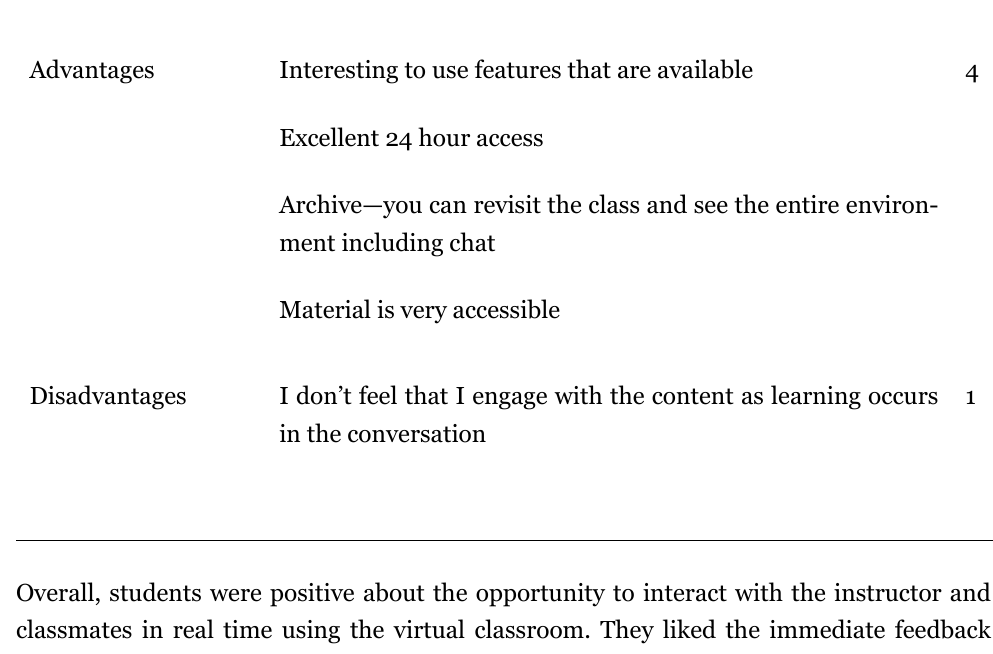
Select Quotations from the Instructor about Strategies and Tools that were Used to Facili- tate the Four Types of